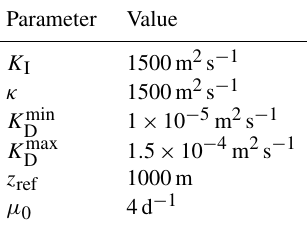
Table B1. Ocean model parameters.